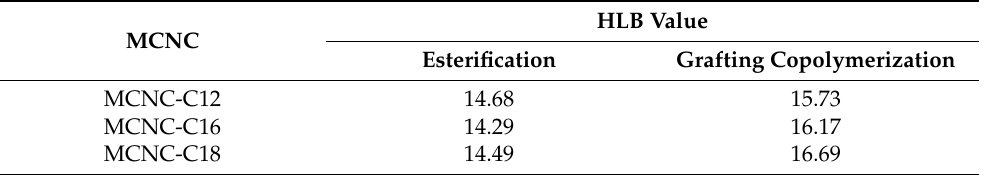
Table 1. HLB value of fatty acid graft